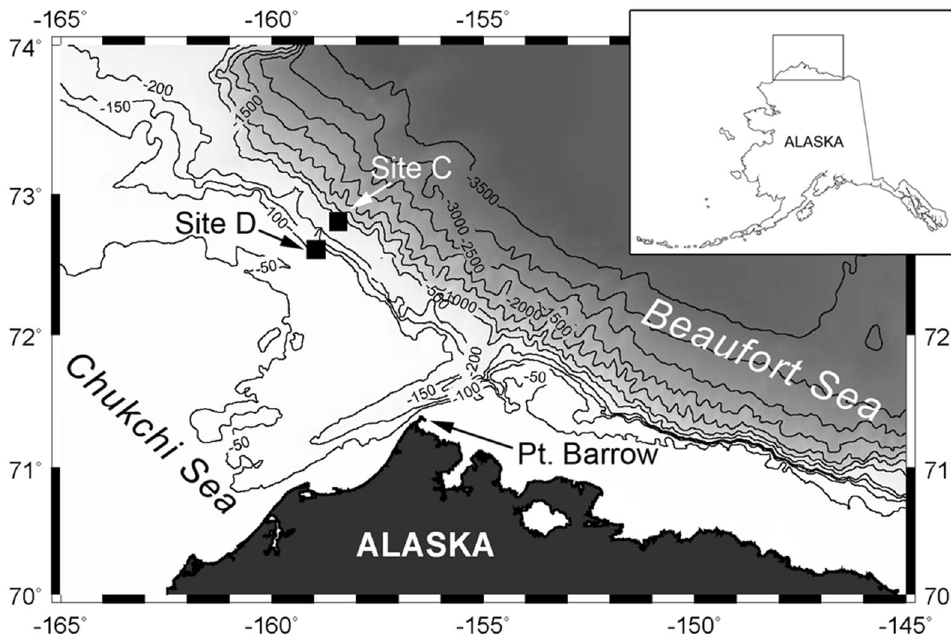
Figure 2. Acoustic recorder deployment sites near Utqiaġvik (Barrow, Alaska, USA) from 2012 through 2013. Contour depths in meters with darker shading indicating deeper depths. Sites C (slope) and D (shelf) at depths 320 and 100 m, respectively. Map created using M_Map mapping package (www. eoas. ubc. ca/ ~rich/ map. html) for Matlab (MathWorks Inc., Natick, MA).